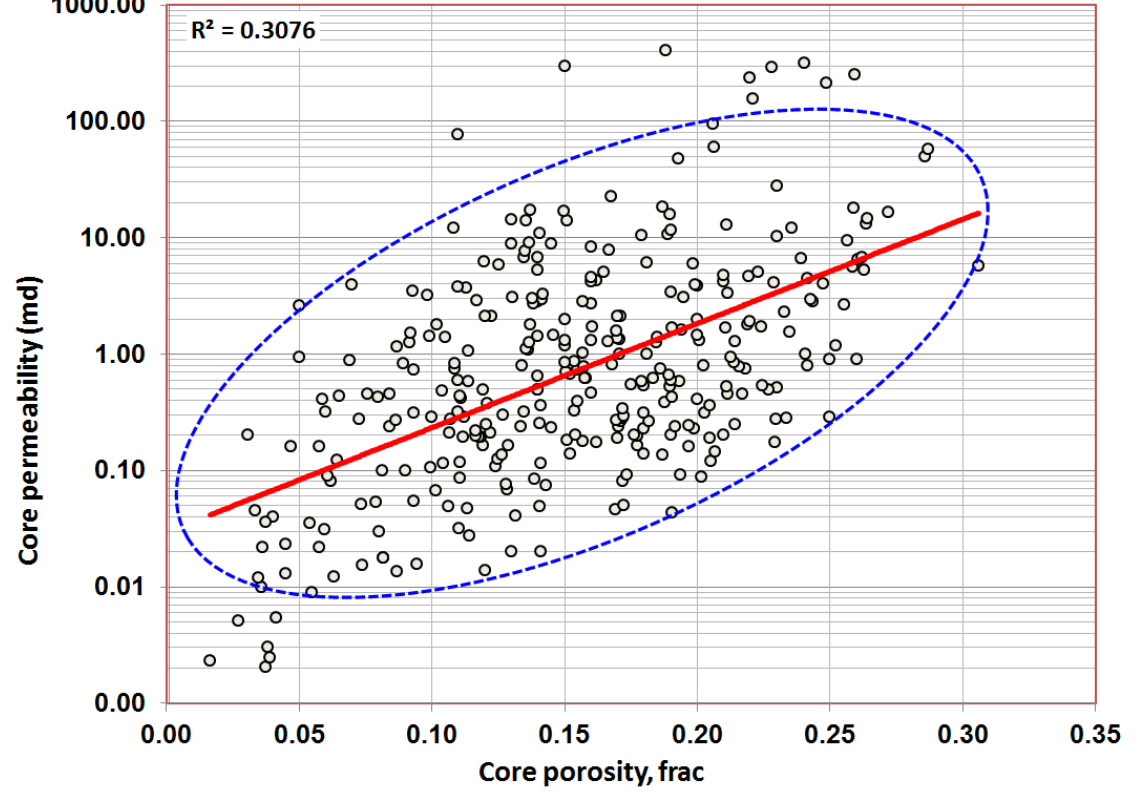
Figure 5. Core porosity versus core permeability for Upper Bahariya